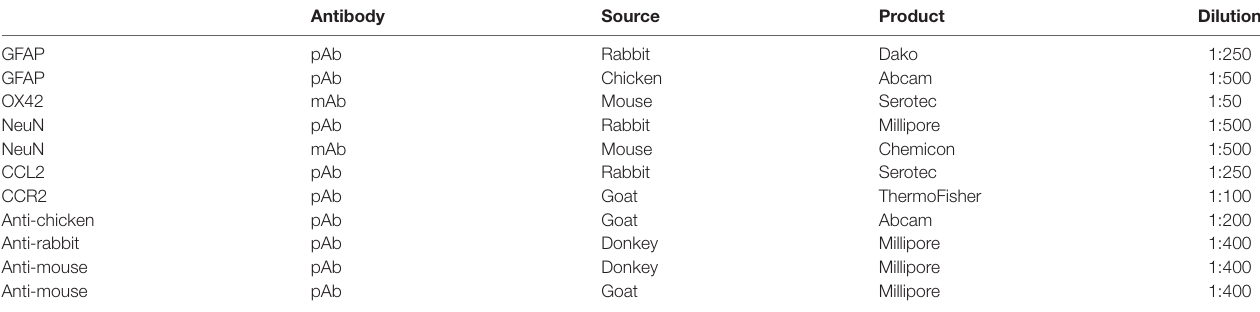
TABLE 1 | List of primary and secondary antibodies used for immunofluorescence detection.